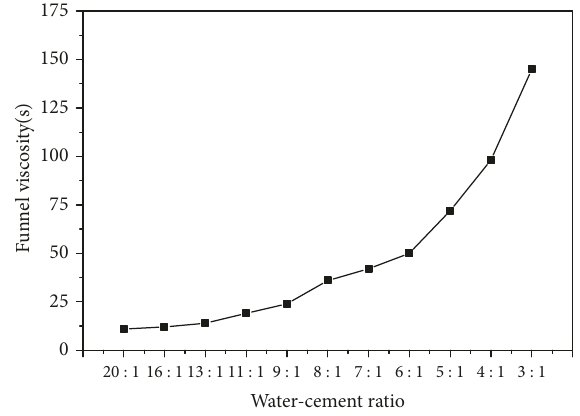
Figure 8: Relationship between water-cement ratio and funnel viscosity of expandable material with high water